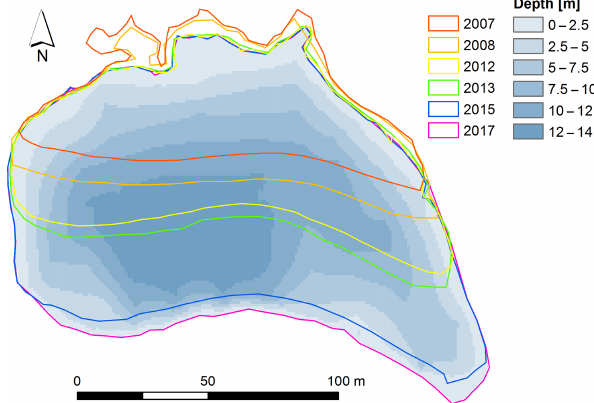
Figure 4. Bathymetric map and area changes of Lake 3 between 2007 and 2017. Lake depth data obtained during a field survey at the site carried out in